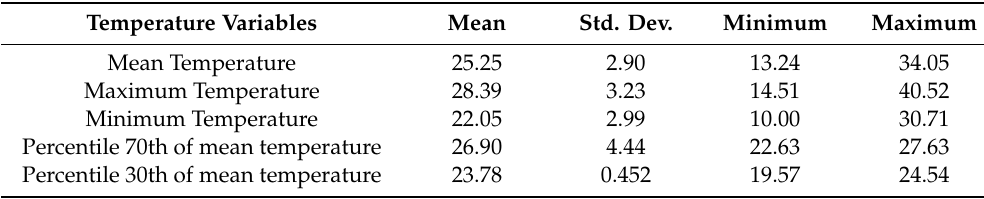
Table 2. Characteristics of temperature, in ◦ C, in summer (1 June–30 September) estimated by UrbClim Model data during the study period 1992–2015 in